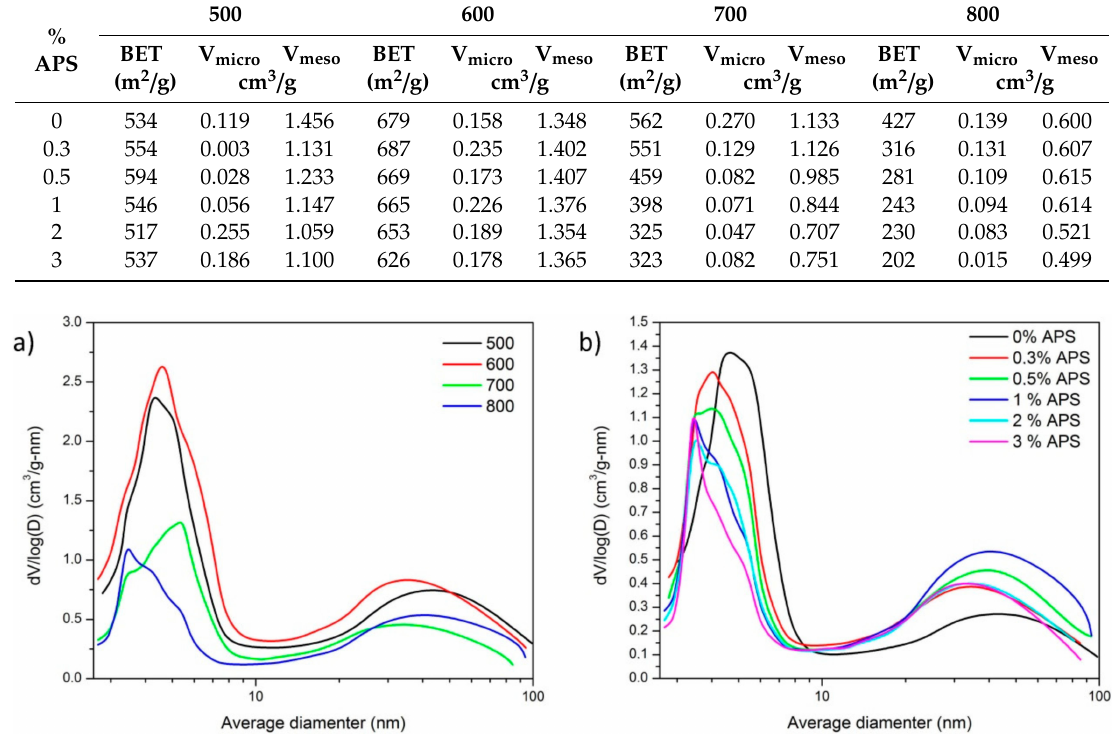
Figure 6. Pore Size Distributions of the TFV loaded particles ( a ) containing 1% silane in solution and pyrolyzed at di ff erent temperatures and ( b ) functionalized with di ff erent amounts of γ -APS and pyrolyzed at 800 ◦